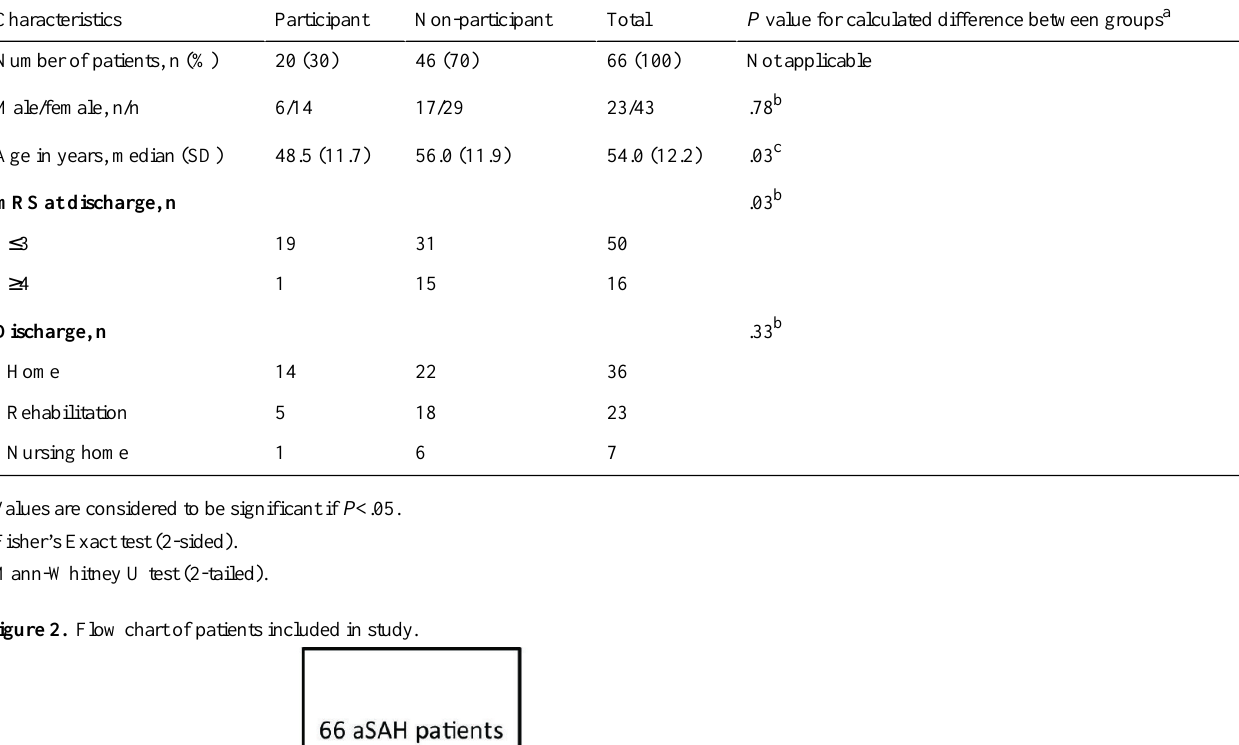
P value for calculated difference between groups a TotalNon-participantParticipantCharacteristics